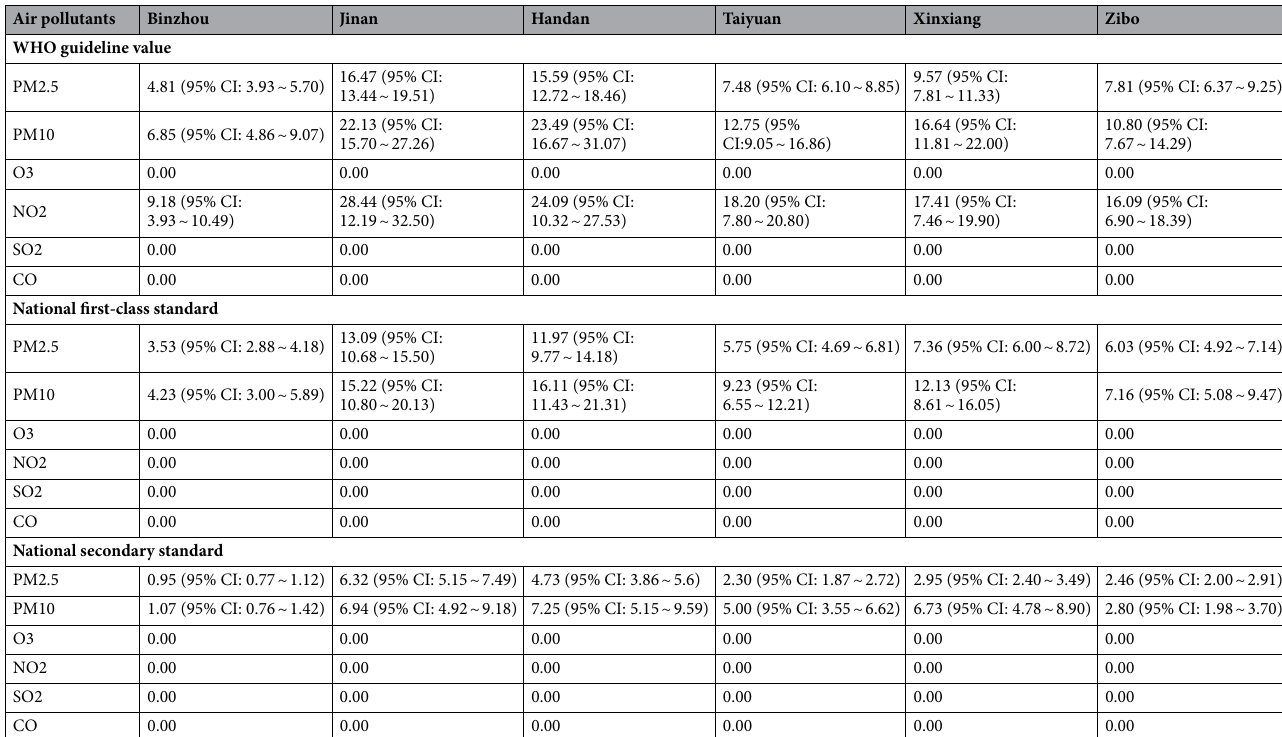
Table 8. Number of deaths that could be avoided by meeting air pollution standards in 2021 (10,000